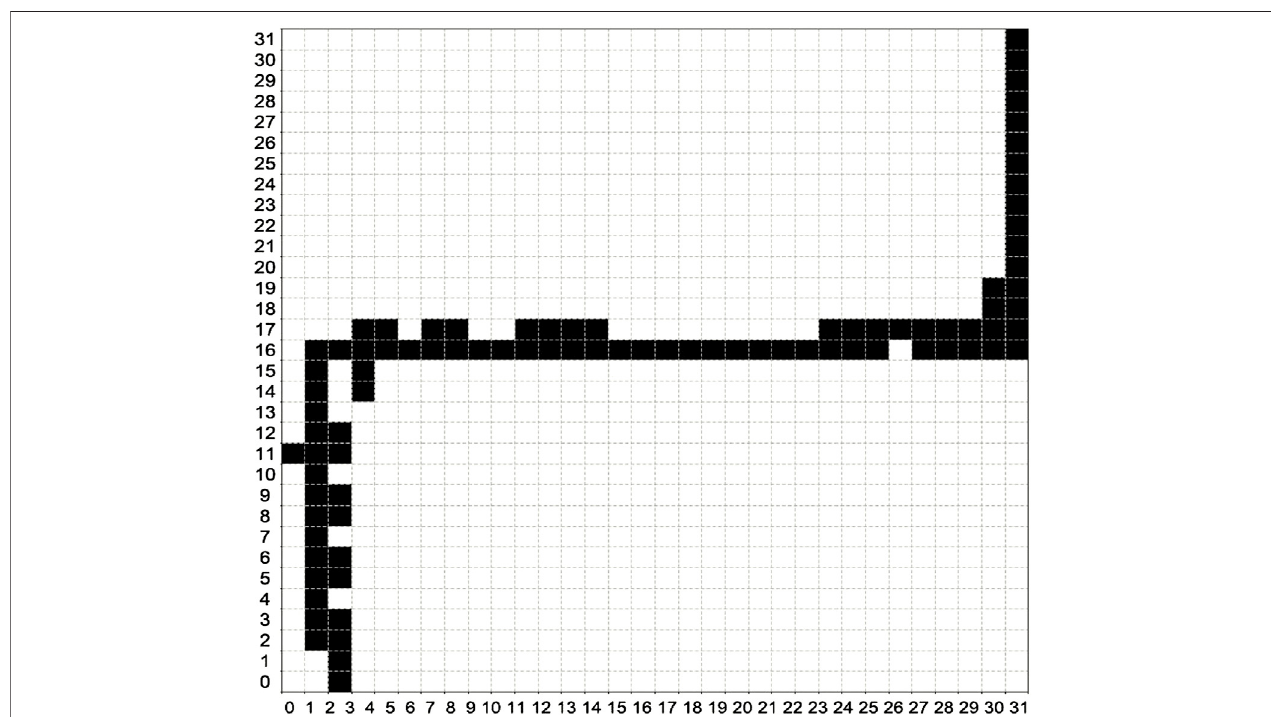
FIGURE 7 | Typical bitmap of the V- △ I trajectory of electric